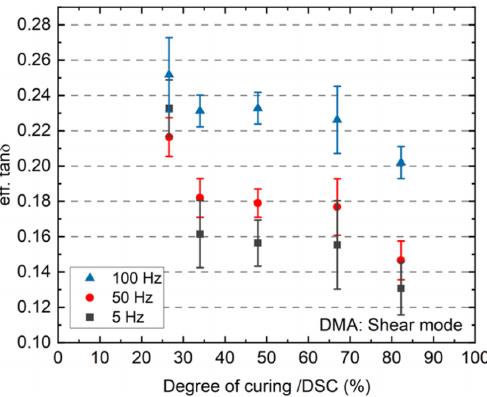
Figure 16. Damping factor calculated from DMA shear mode of EVA-backsheet laminates as function of 5 different DoCs.